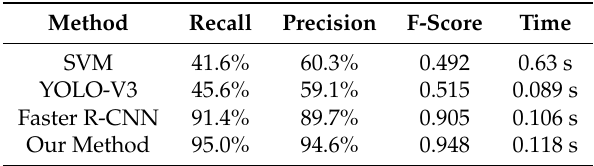
Table 5. Performance comparison between different